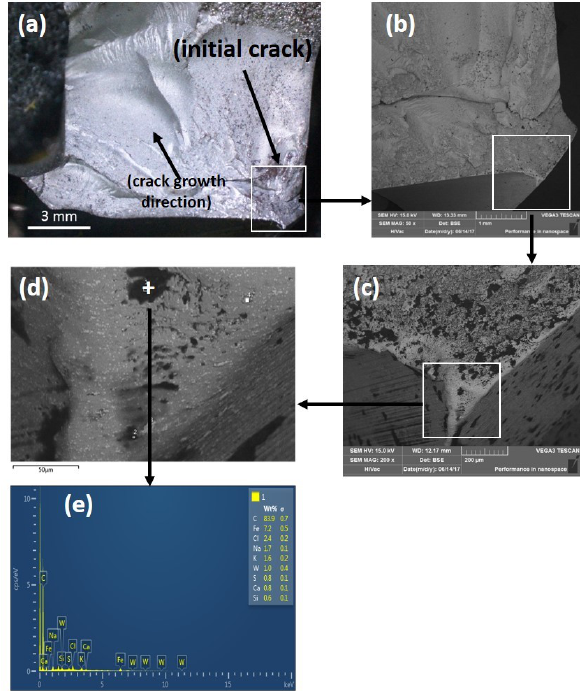
Figure 6: The initial crack exposure (a) crack growth direction (b) macro view of initial crack, (c) detailed view of initial crack, (d) visi- ble carbide, (e) EDS of carbide of them. It is well known that material of end mill is steel alloy in which the most alloying elements are strong car- bide former elements such as Mo, V, W, and Cr. The in- homogeneous distribution of them leads to form the